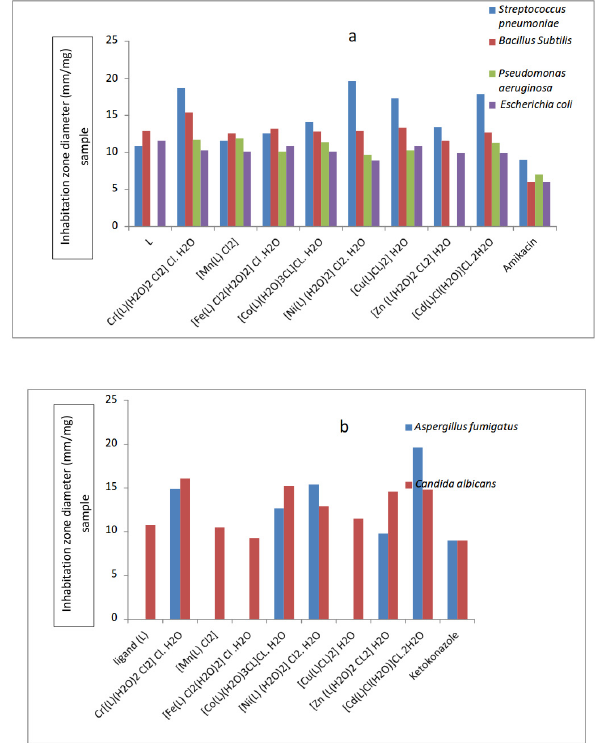
Figure 5. Biological activity of Schiff base ligand and its metal complexes against ( a ) Different bacterial species ( b ) Different fungal species.